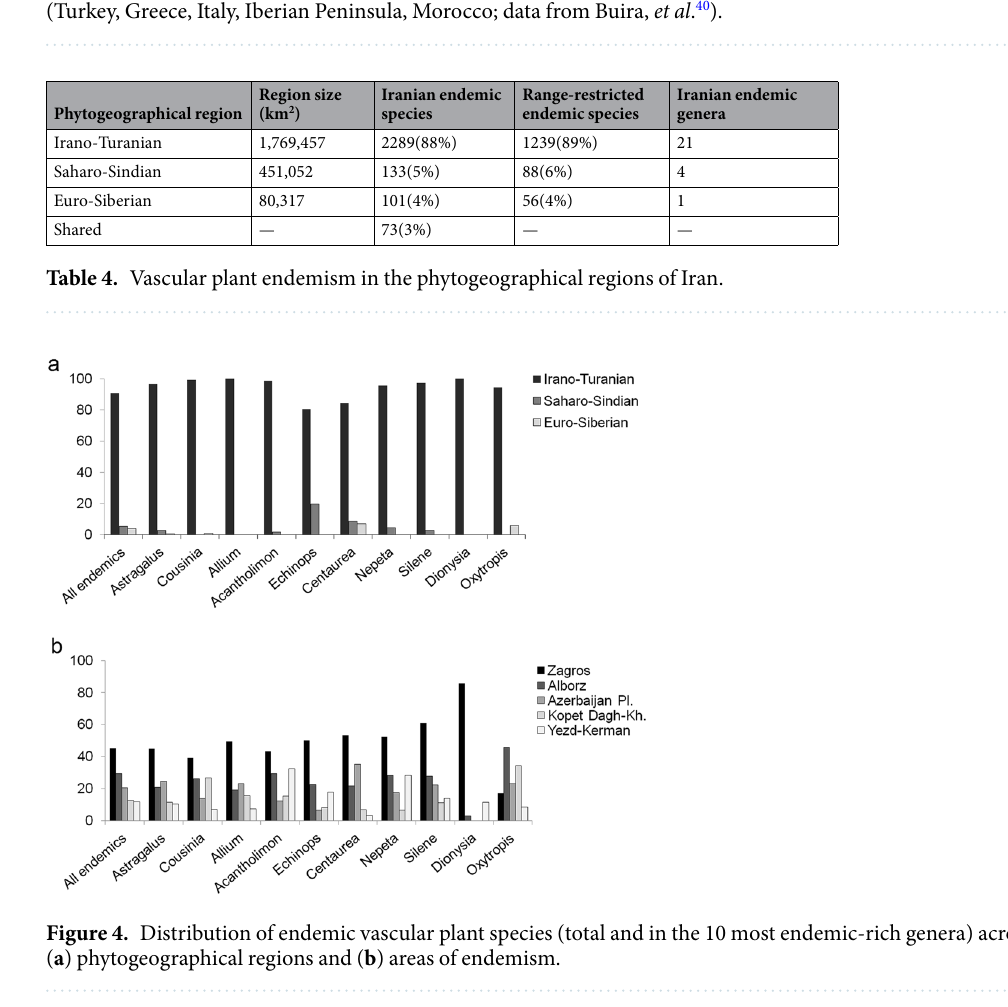
Phytogeographical region